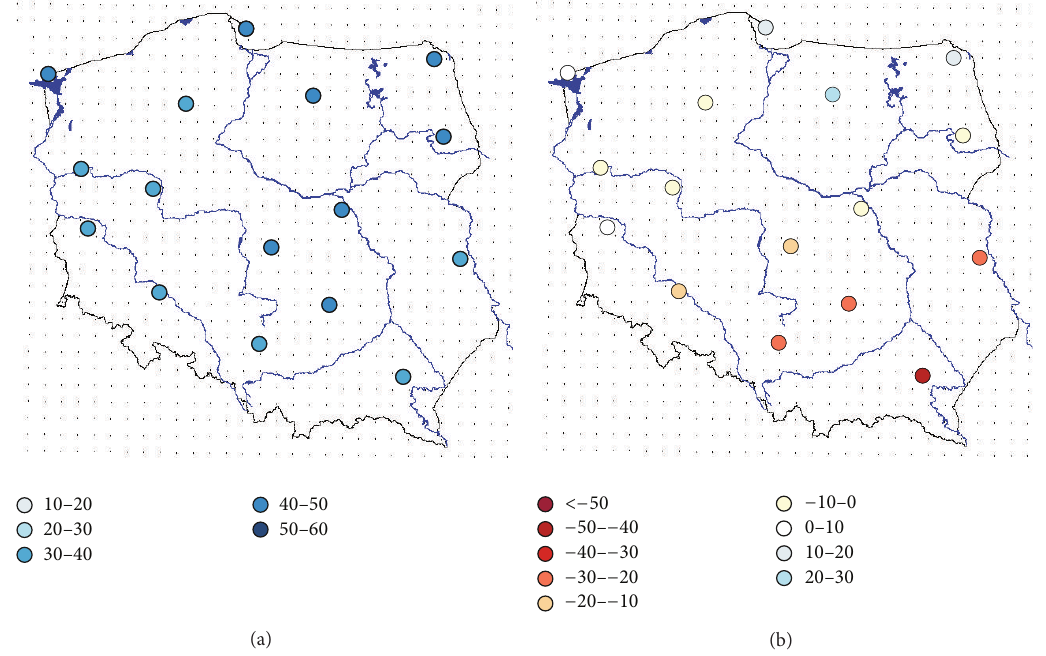
Figure 6: The changes of winter (a) and summer (b) precipitation [in mm] in the future (2061–2090) compared to the control period 1961– 1990, based on five models.